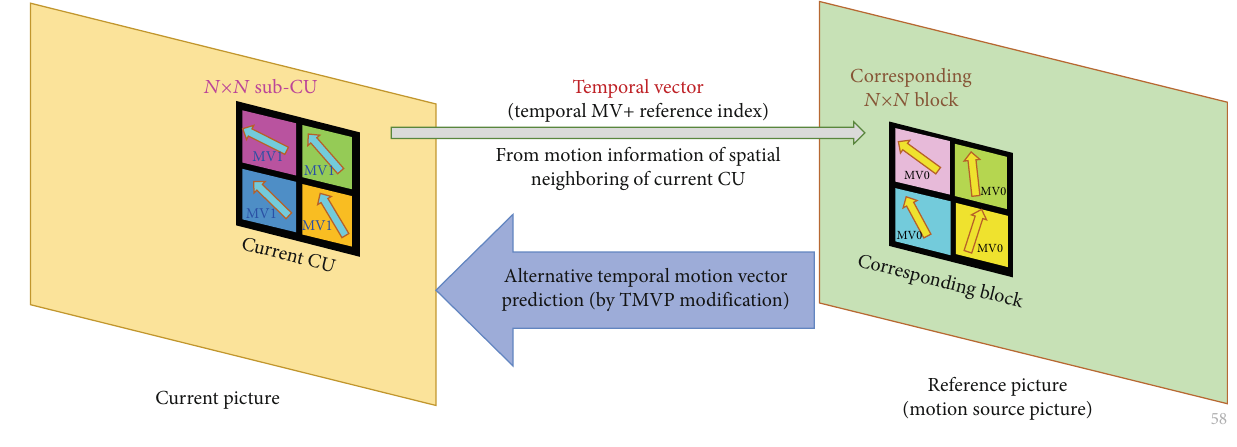
Figure 5: ATMVP motion vector prediction.